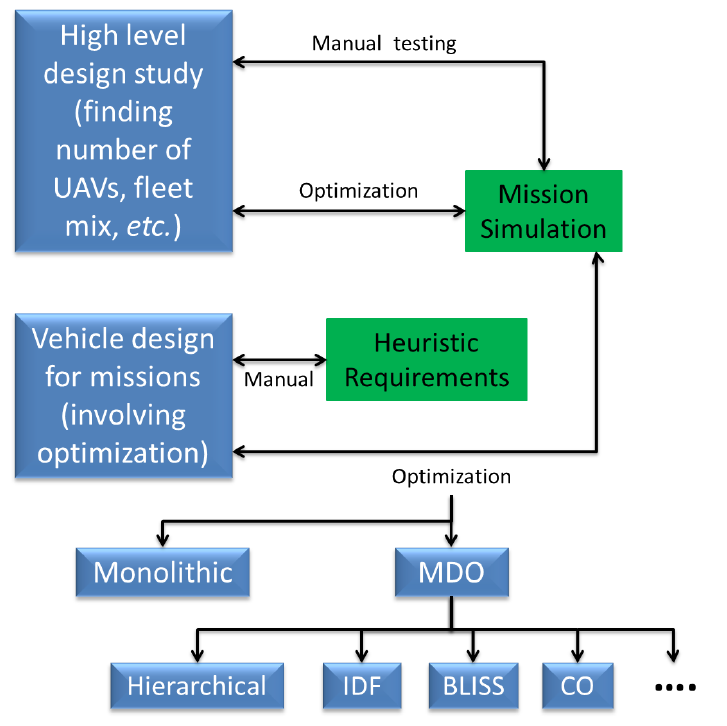
Figure 21. Overview of kind of design studies performed in literature and options for